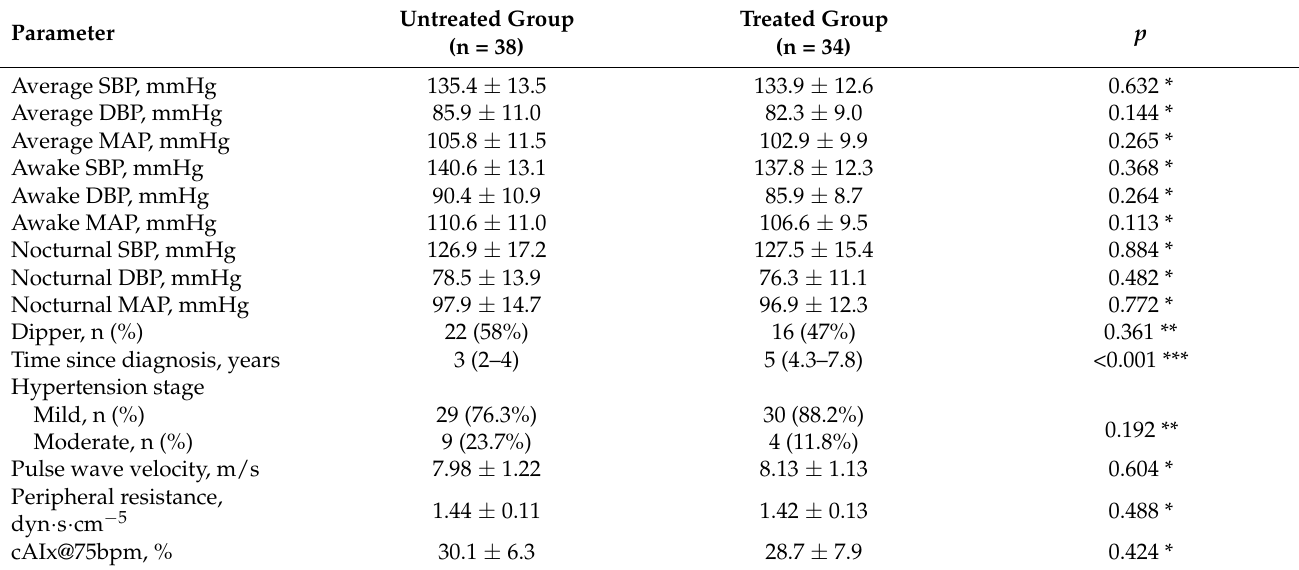
Table 2. Ambulatory blood pressure and pulse wave analysis comparison between the treated and untreated